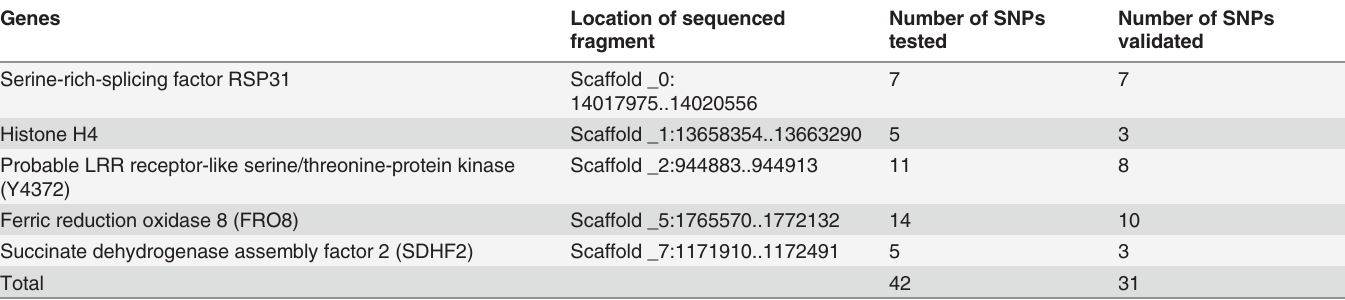
Table 4. Summary of SNP validation in ‘ BG ’ , ‘ WR1 ’ , ‘ ZO ’ and ‘ RL ’